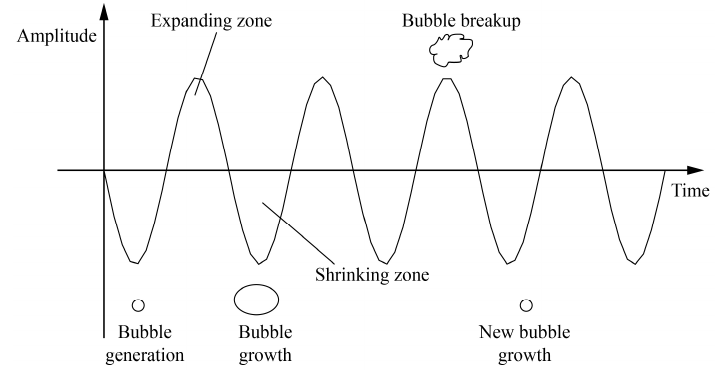
Figure 2. Schematic of cavitation mechanism.